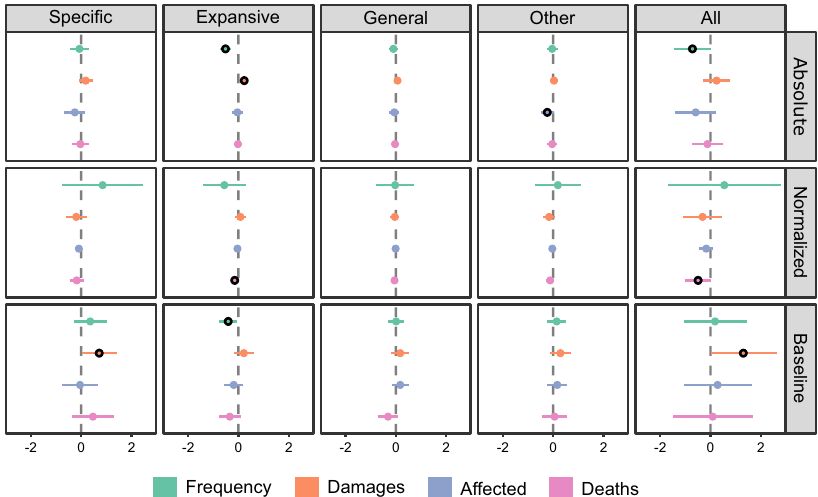
Fig. 2 Estimated effects size. Plots showing estimated effect size of absolute, normalized, and 15-year baseline measures of disaster event frequency, economic damages, affected population, and fatalities on adaptation action types. Estimates from multiple OLS regression models with time lag, city population, political stability, meritocracy, stakeholder diversity, and local government power as controls. Highlighted circles indicate estimates signi fi cant at p < 0.1 or better, while the error bars display the 95% con fi dence interval. Full models are shown in Supplementary Tables 33 –